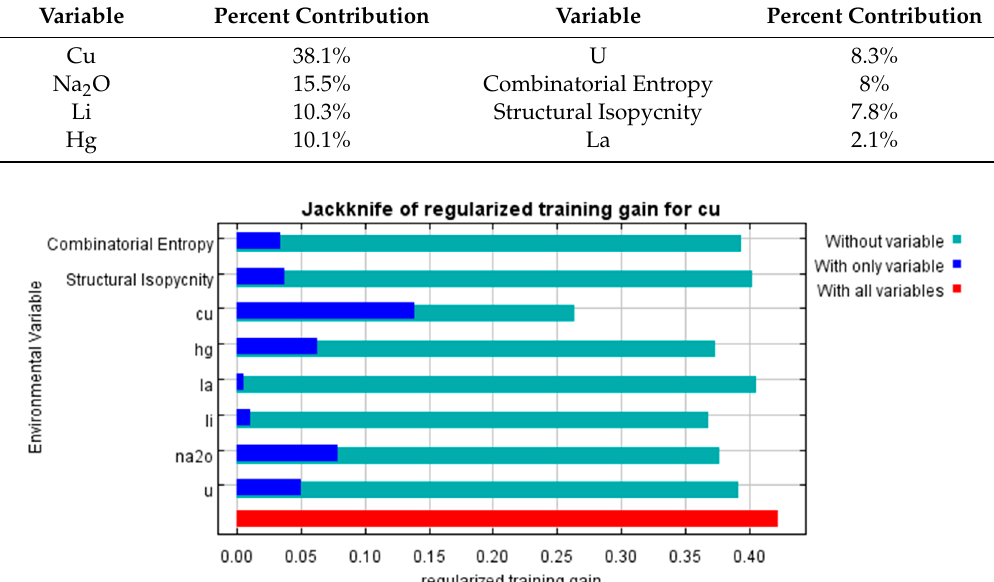
Table 3. The contribution of ore-controlling factors.